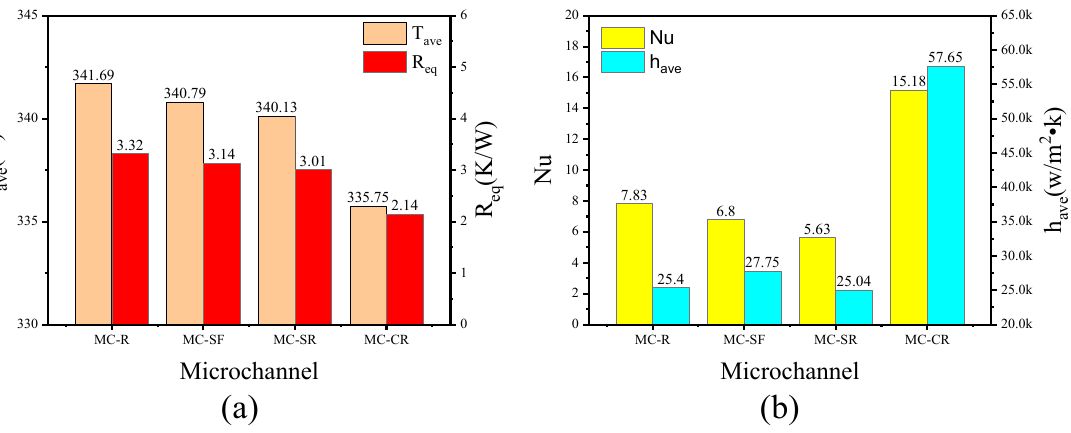
Figure 14. The performance of MC-R, MC-SF, MC-SR, and MC-CR when the pressure drop is 4.5 kPa. ( a ) The average temperature and the equivalent thermal resistance; ( b ) the Nu and average convective heat transfer coefficient.